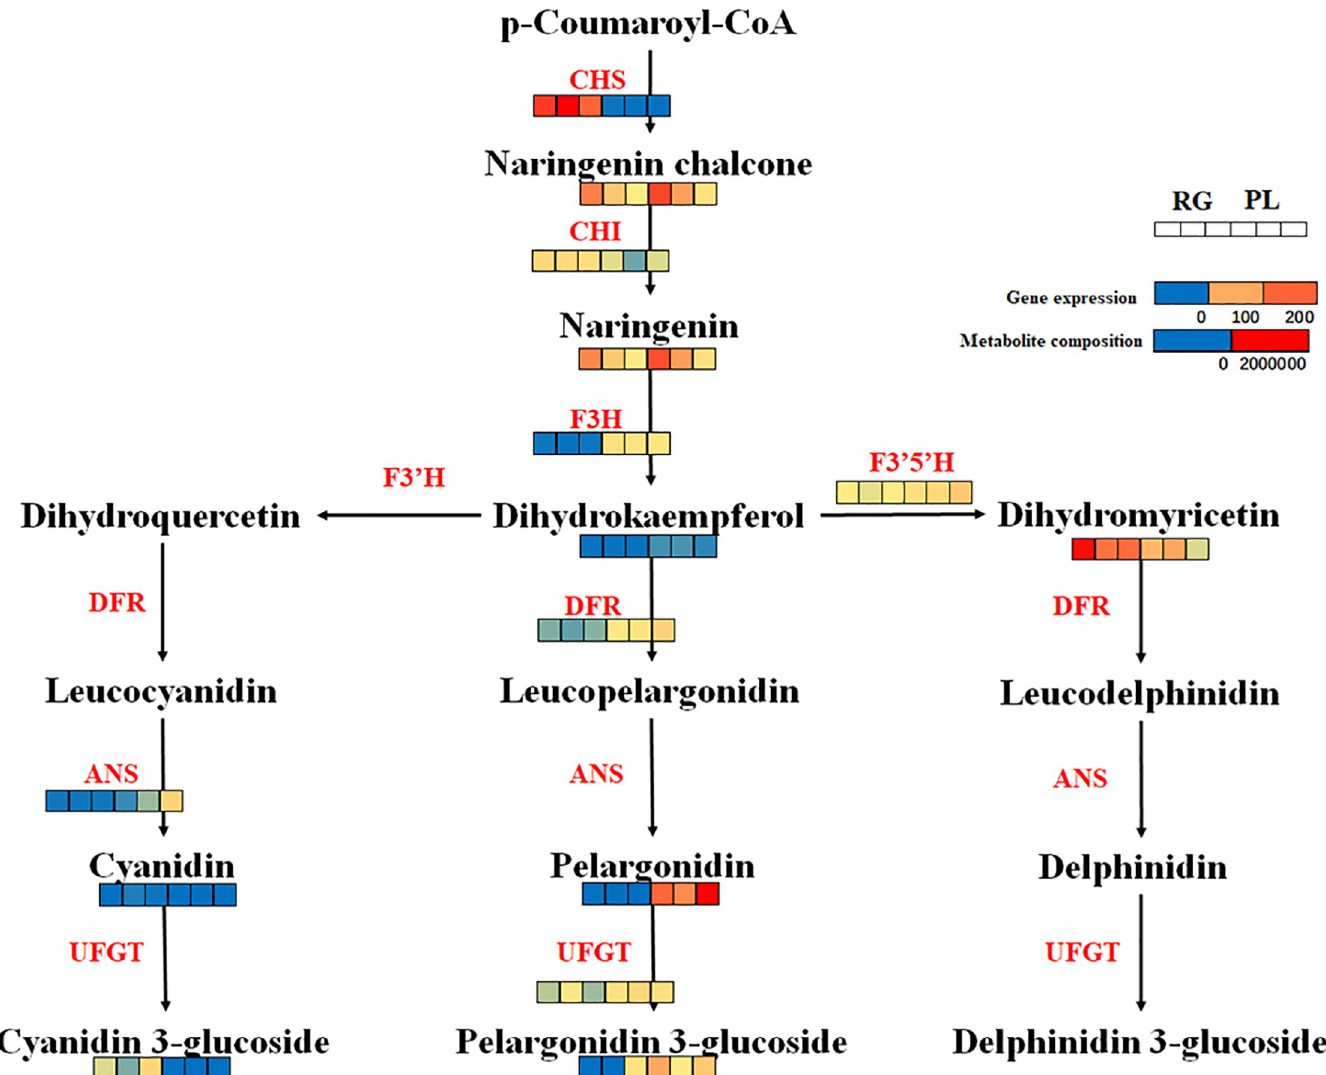
Fig 7. Biosynthetic pathway of anthocyanins. This pathway is constructed based on the KEGG pathway. Each coloured cell represents the normalized intensity of each compound ion according to the colour scale (three biological replicates × two cultivars, n = 6). The expression levels of chalcone synthase (CHS), chalcone isomerase (CHI), flavanone 3-hydroxylase (F3H), flavonoid 3 0 -hydroxylase (F3’H), flavonoid 3 0 ,5 0 -hydroxylase (F3’5’H), dihydroflavonol 4-reductase (DFR), anthocyanidin synthase (ANS) and flavonoid 3-O-glucosyltransferase (UFGT) are shown.